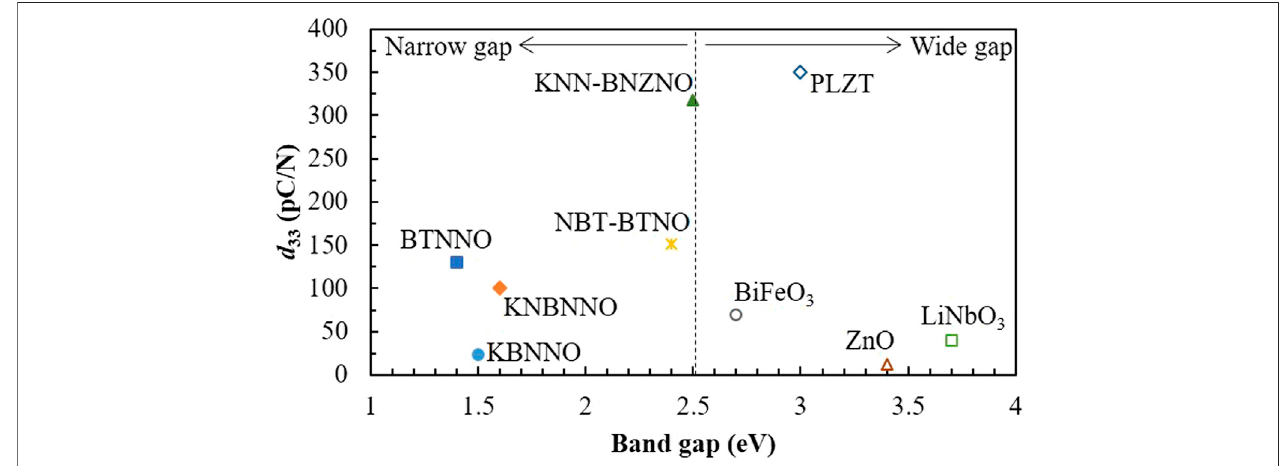
FIGURE1| Bandgapsand d 33 valuesofnarrowbandgapandwidebandgappiezoelectricsdiscoveredtodate.KBNNO – (K,Ba)(Nb,Ni)O 3- δ ;KNBNNO – (K,Na,Ba) (Nb,Ni)O 3- δ ; KNBNZNO – (K 0.48 Na 0.52 )NbO 3 -(Bi 0.5 Na 0.5 ) (Zr 0.55 Ni 0.45 )O 3- δ ; NBT-BTNO – (Na 0.5 Bi 0.5 )TiO 3 -Ba(Ti 0.5 Ni 0.5 )O 3- δ ; BTNNO – Ba(Ti,Ni,Nb)O 3- δ . Data are extracted from literature (Yue and Yi-jian, 2003; Bavbande et al., 2012; Kumar and Kim, 2012; Mamoun et al., 2013; Bowen et al. 2014; Paillard et al., 2016; Wu et al. (2016);